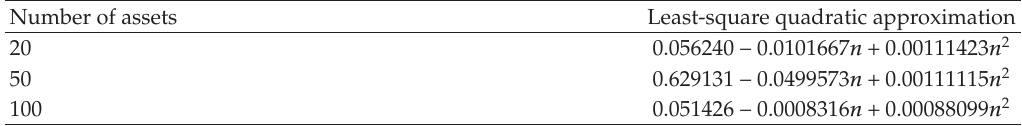
Table 4: Some least-square approximation of the CPU-time (cid:6) in seconds (cid:7) of KTEF - S as a function of the number of processed cases.